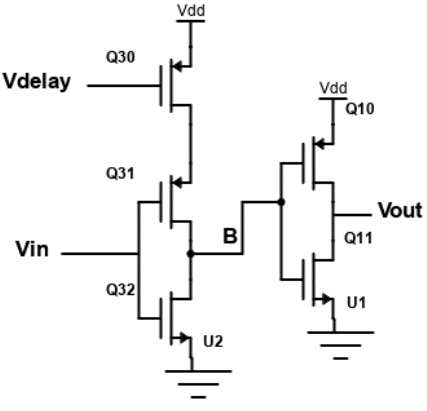
Figure 3. Schematic of proposed variable-delay element.